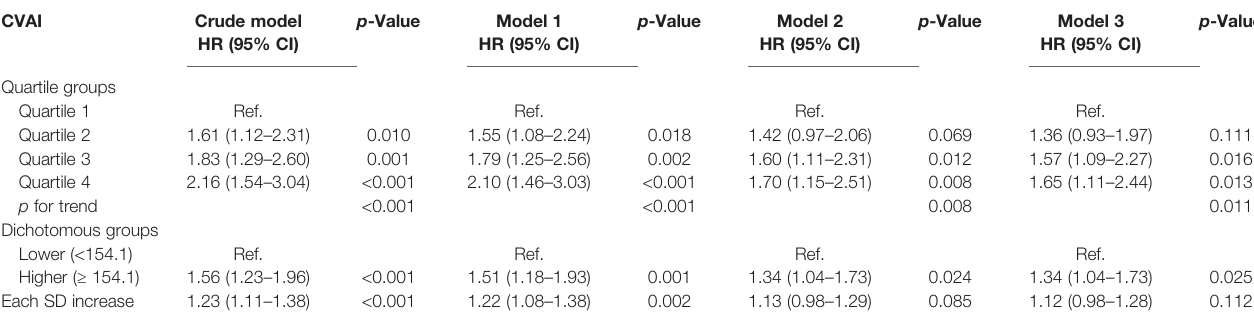
TABLE 2 | Multivariable Cox regression for the association between CVAI and incident renal